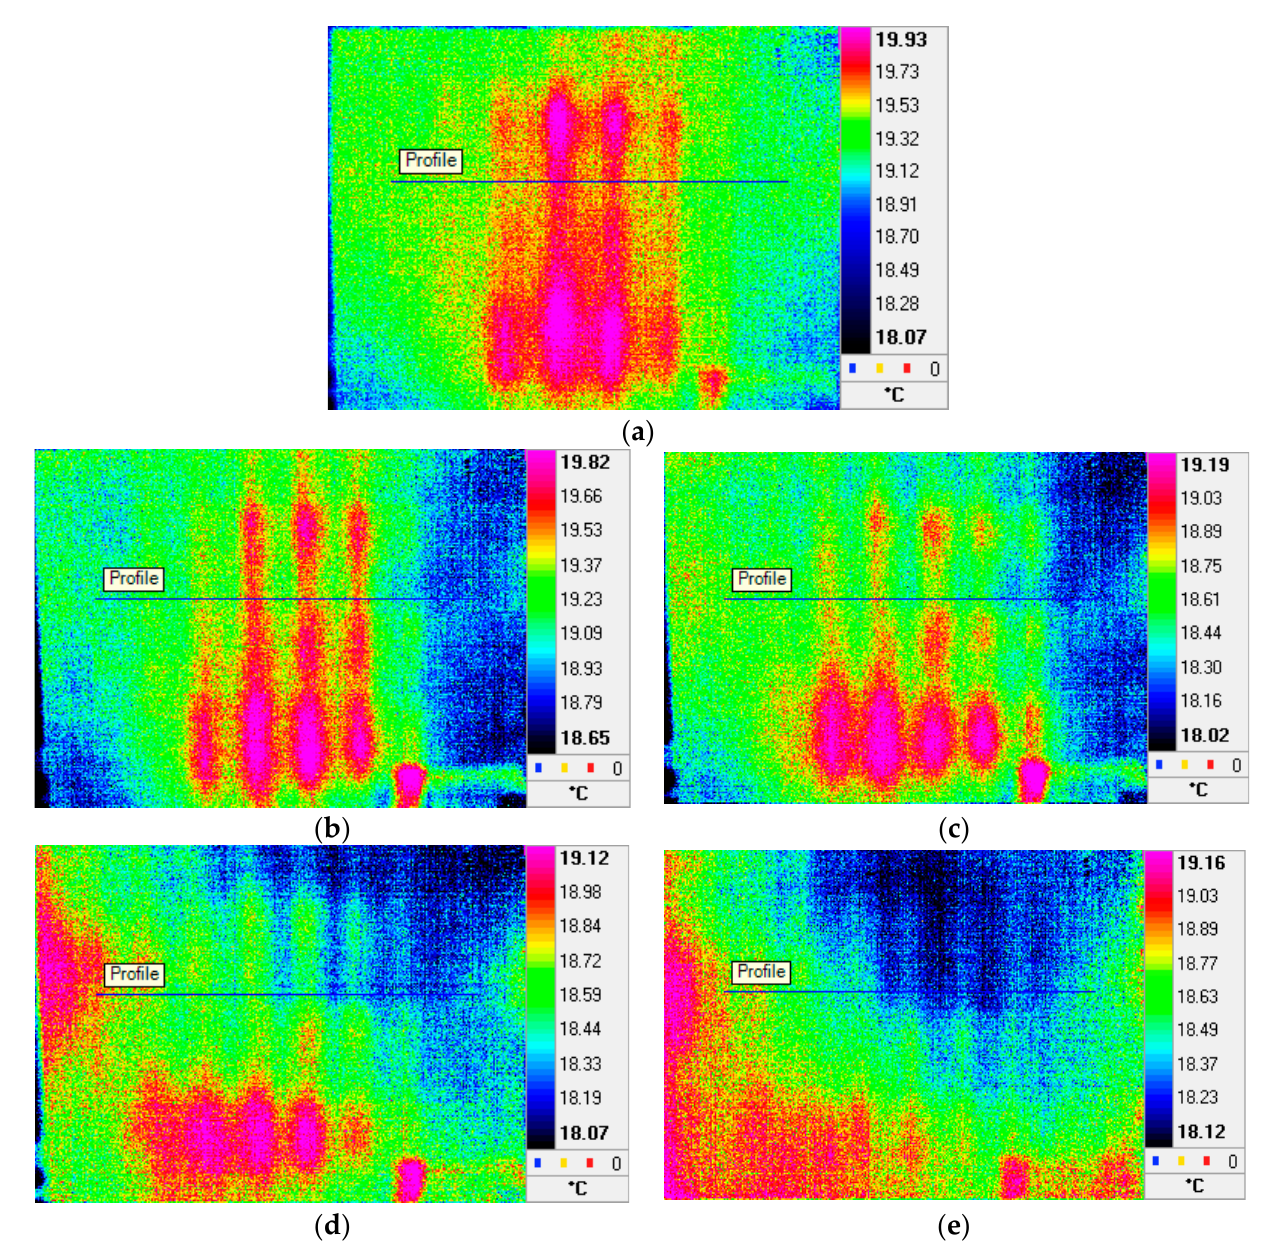
Figure 6. Thermograms from the detection of RC wall by transmission approach at different instants for different angles of incident waves ( θ i ): ( a ) Thermogram at 172 s when θ i = 0°; ( b ) Thermogram at 243 s when θ i = 15°; ( c ) Thermogram at 288 s when θ i = 30°; ( d ) Thermogram at 290 s when θ i = 45°; ( e ) Thermogram at 281 s when θ i = 60°.